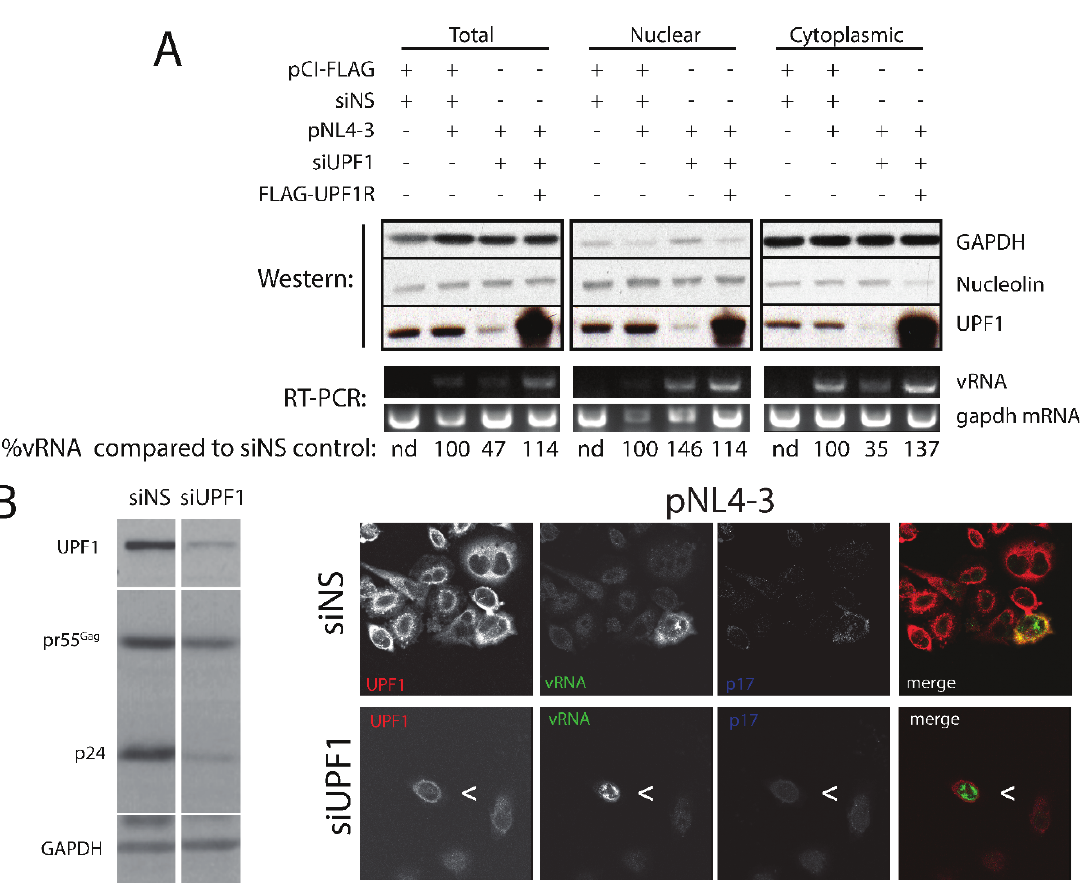
Figure 2. UPF1 depletion increases the abundance of vRNA in the nucleus while UPF1 Rescue enhances cyto-plasmic vRNA levels. ( A ) HeLa cells were mock transfected with pCI-FLAG and non-silencing siRNA (siNS) or co-transfected with HIV-1 proviral pNL4-3 DNA and pCI-FLAG and siNS. UPF1 was depleted by siUPF1 and UPF1 expression was rescued with FLAG-UPF1Rescue (UPF1R). At 30h post-transfection, cells were harvested and cytoplasmic-nuclear fractionation analysis was carried out as described in Materials and Methods. Western blot analysis was performed GAPDH (enriched in the cytoplasmic), Nucleolin (enriched in the nucleus), and UPF1 (identifying endogenous and overexpressed proteins). RNA was isolated from cell extracts and steady-state levels of vRNA and gapdh mRNA was measured by RT-PCR. vRNA levels were quantified by densitometry with ImageJ using gapdh mRNA signal intensity for normalization; pNL4-3 + siNS condition was set at a 100%. nd, not detectable. ( B ) Cells were mock-depleted with nonsilencing siRNA (siNS) or depleted using siUPF1 as described in Materials and Methods. At 40–48 h post-transfection, cells were harvested for western blotting for UPF1 (endogenous), Gag (identifying pr55Gag and p24) and GAPDH (loading control) (on left) and FISH/IF co-analyses for UPF1 (red), vRNA (green) and Gag (blue) (with merged renditions on right). UPF1 depletion led to decreased Gag expression as shown earlier (left panel; Ajamian et al ., 2008) but also led to a blockade to vRNA nuclear export (white arrowhead < in lower row of right panel) in >80% cells examined ( n = 48). See results for additional discussion of these